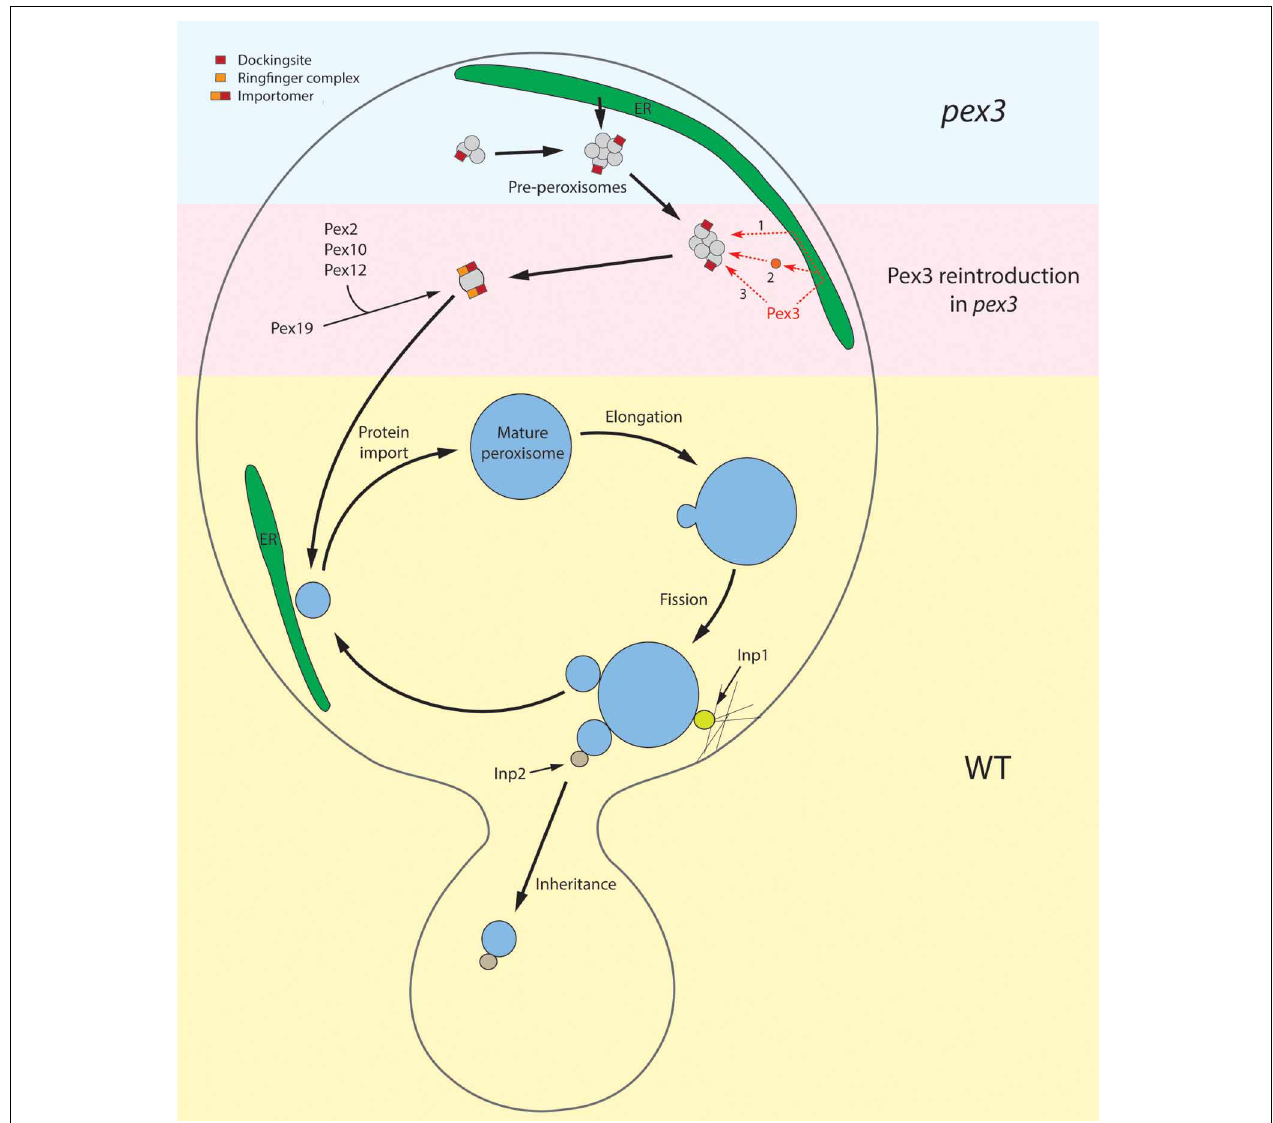
FIGURE 2 | Schematic overview of peroxisome re-introduction in pex3 and peroxisome proliferation in WT cells. The upper part of the cell represents the situation in pex3 cells. These cells contain vesicular structures that harbor Pex13 and Pex14, proteins of the receptor docking site. How these proteins are sorted to these membranes is unknown. These structures may derive by proliferation of pre-existing ones or be formed from the ER. The pre-peroxisomes are the target for re-introduced Pex3, which may reach these structures via the ER (1), upon incorporation in vesicles that derive from the ER and subsequently fuse with pre-peroxisomes (2) or sort directly